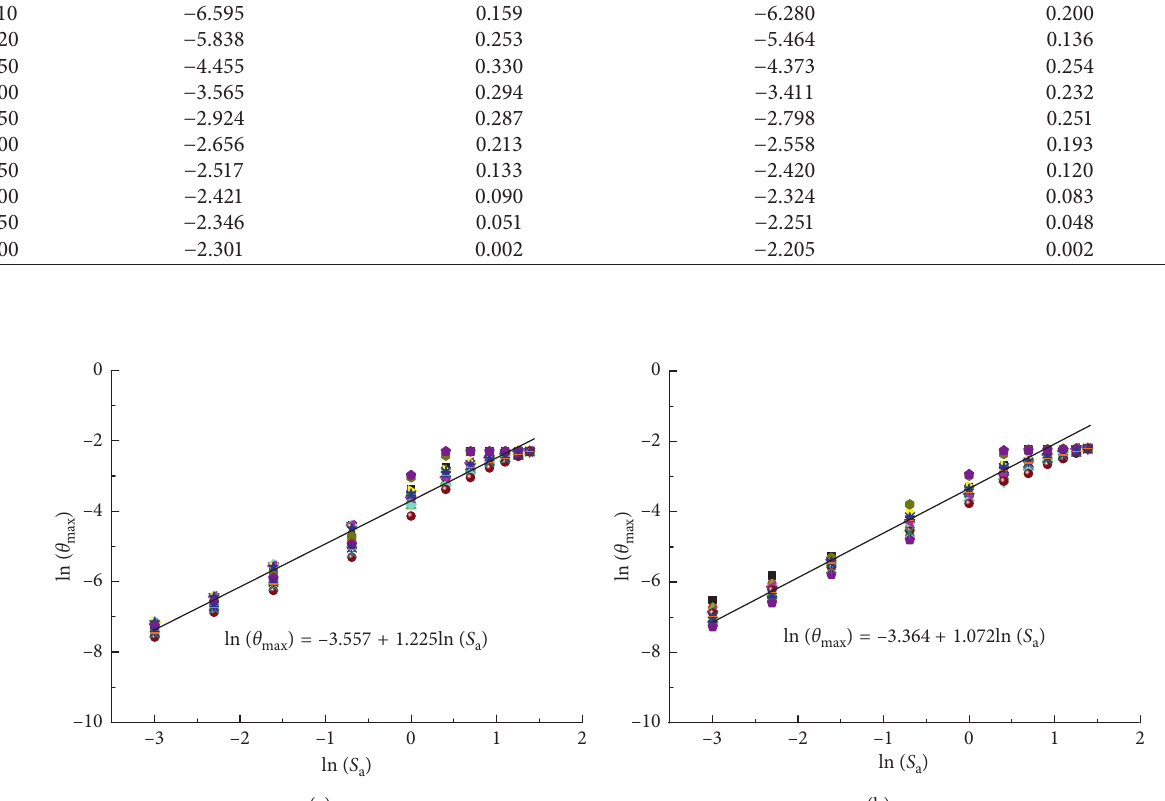
Figure 13: Linear regression analysis. (a) Main shock. (b) Main